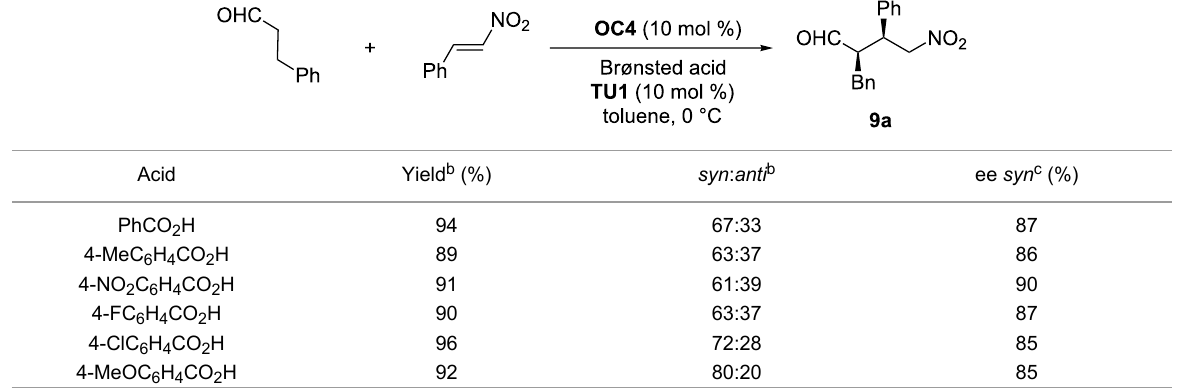
Table 5: Screening of benzoic acids as additives for Michael addition of 3-phenylpropionaldehyde to trans - β -nitrostyrene using catalysts OC4 . a